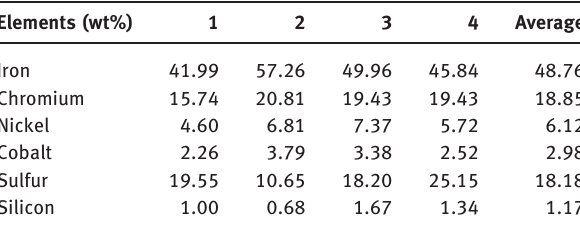
Table 13: Element composition of welded duplex SS 2205.